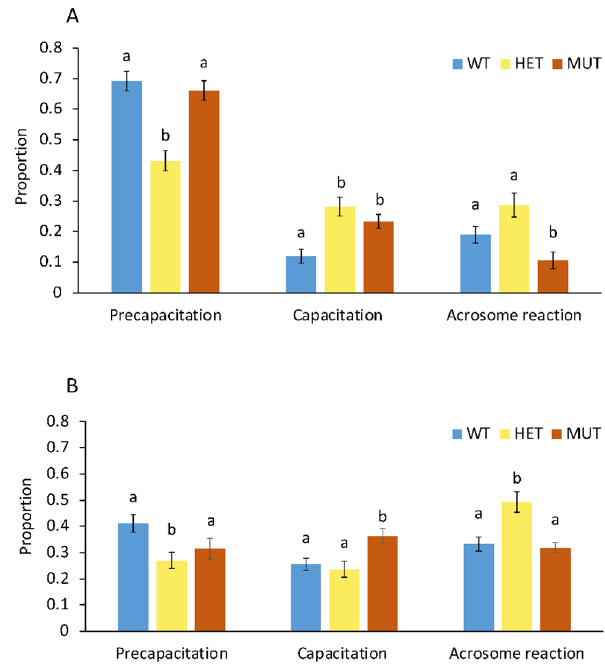
Figure 4. Effect of ABHD16B genotype on capacitation of spermatozoa . Three genotypes are shown as wild type (WT, blue bars), heterozygous (HET, yellow bars), and homozygous carriers (MUT, red bars). ( A ) Analysis of spermatozoa at the beginning of the incubation (0 h). ( B ) Analysis of spermatozoa after 2 h of incubation. Staining and evaluation of spermatozoa was carried out as described in the Materials and Methods section and also shown in Figure 3. Error bars indicate standard deviations. Small letters (a, b) show significant differences at a significance level of p < 0.05.